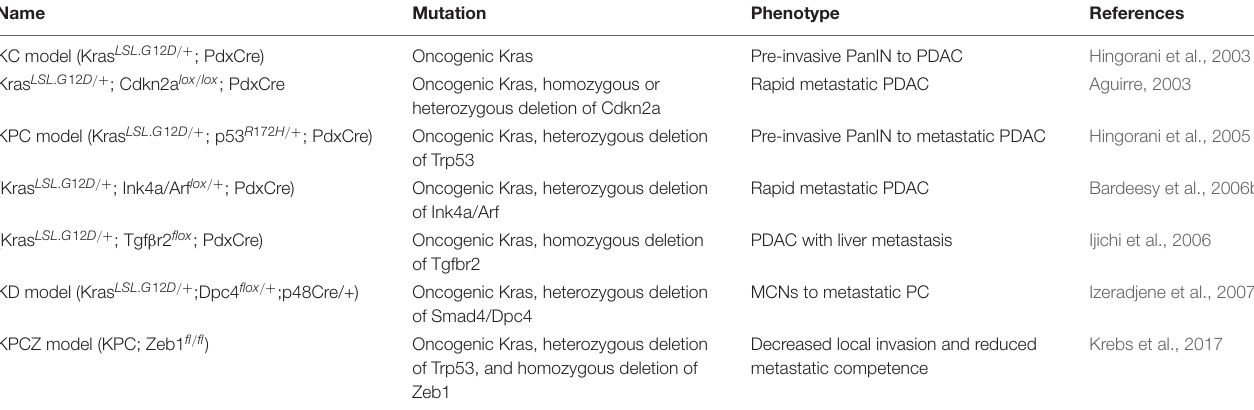
TABLE 4 | Genetically engineered mouse models of pancreatic cancer summary of the most common GEMMs of PDAC driven by